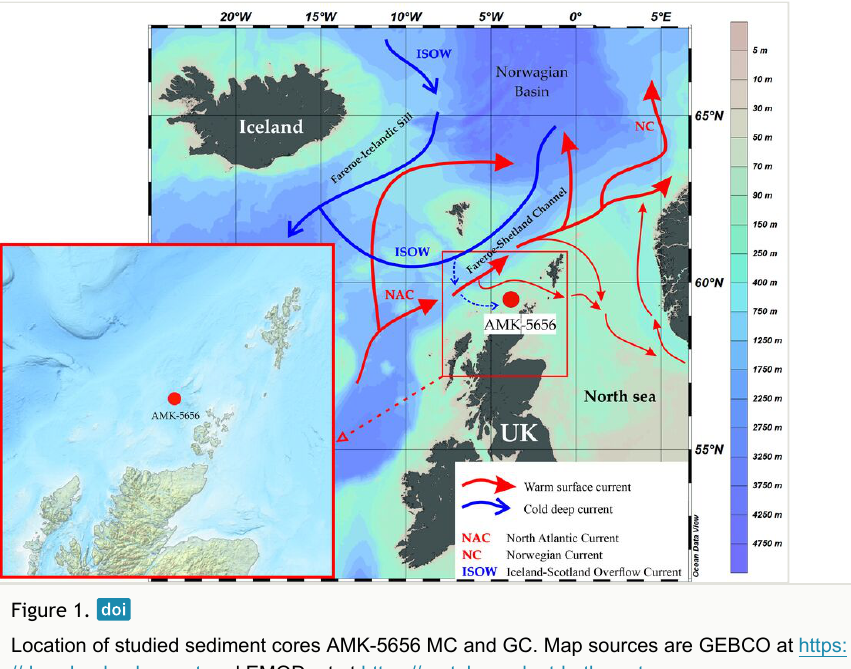
Location of studied sediment cores AMK-5656 MC and GC. Map sources are GEBCO at https: //download.gebco.net and EMODnet at The NWSS is a shallow water region of western North Atlantic Ocean dominated by the warm saline surface water of the North Atlantic Current branch crossing the NWSS from west to east between Orkney and Shetland (Anonymous 2022a). The cold deep water of Iceland-Scotland Overflow Current coming from the north via the Faroe-Iceland Channel can also influence the local bottom environments (Rasmussen et al. 2002, Sejrup et al. 2004). A prevailing sediment type in the Westray Basin is muddy sand or slightly gravelly AMK-5656 MC and GC.